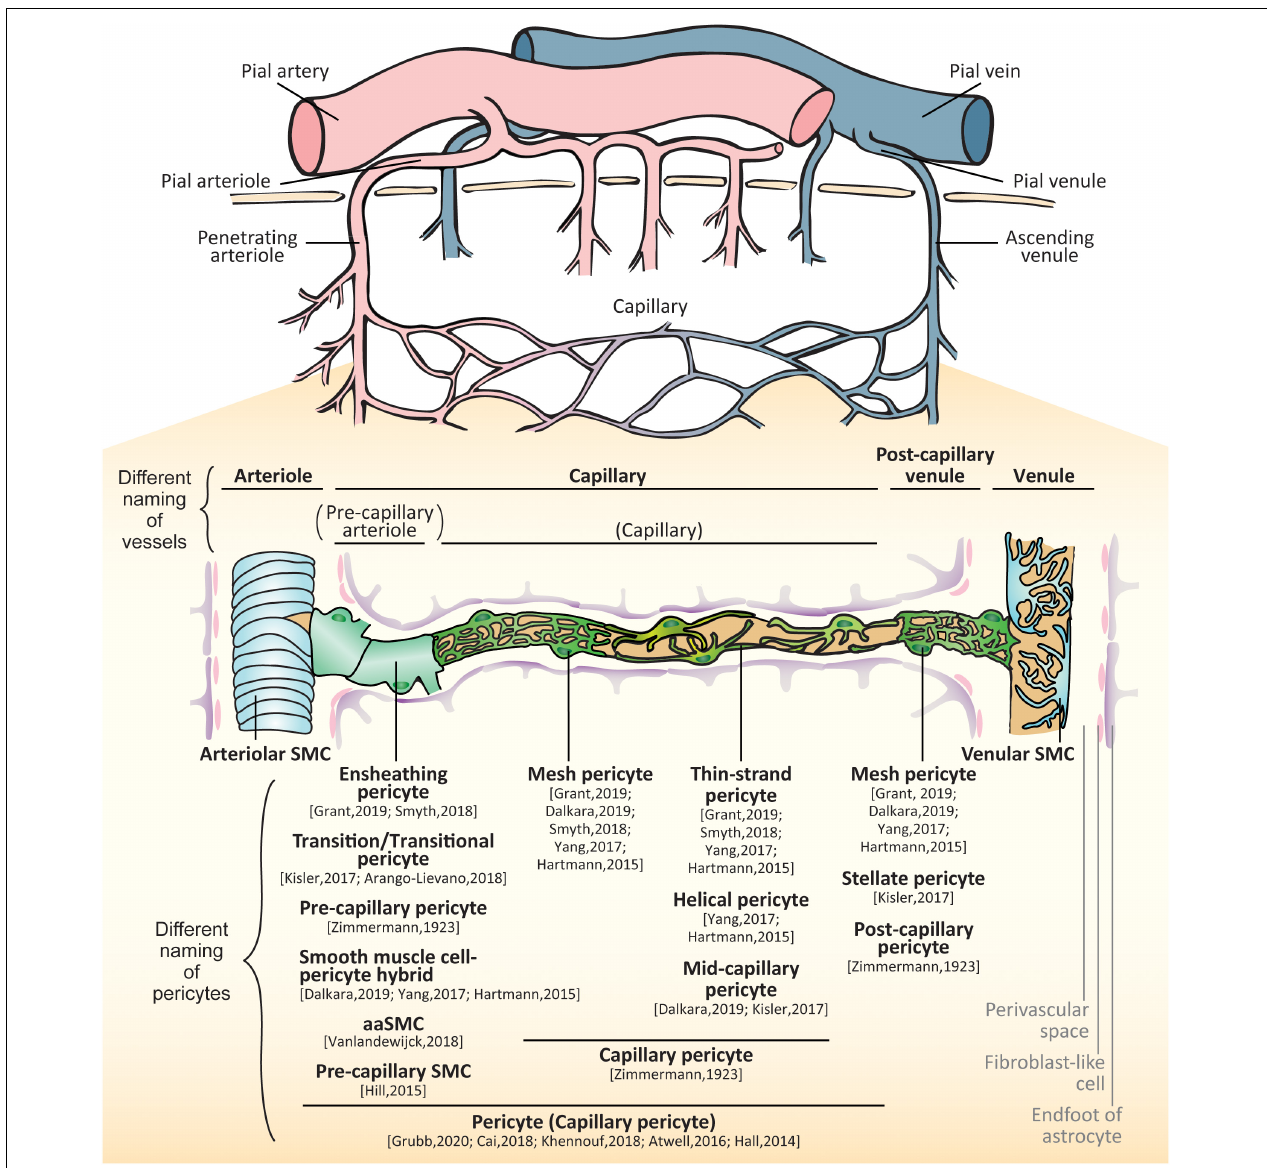
FIGURE 1 | Brain vessels and mural cells. The pial arterioles branch from pial arteries which follow the outer rim of the brain via the meninges. The arterioles penetrate perpendicularly into the brain parenchyma (penetrating arteries) and further split into smaller arterioles. As their diameters and constituent cell types are changed, the vessels make a transition to capillaries. The capillary join to form venules that collect into pial venules and further into pial veins. In the small vessels, there are two types of mural cells separately located outside of endothelial layer: vascular smooth muscle cells (SMCs) and pericytes. SMCs are localized at the arteries, arterioles, venules and veins whereas pericytes are localized at the capillaries and post-capillary venules. The proximal branches coming off penetrating arterioles are sometimes called as pre-capillary arterioles. The subtypes of pericytes are differently called: ensheathing pericytes, transitional pericytes, pre-capillary pericytes, smooth muscle cell-pericyte hybrids, arteriole SMC (aaSMCs), or pre-capillary SMCs in a few branches from arterioles; capillary pericytes, mesh pericytes, thin-strand pericytes, helical pericytes, or mid-capillary pericytes in the middle part of capillary; mesh pericytes, stellate/stellate-like pericytes, or post-capillary pericytes in the post-capillary